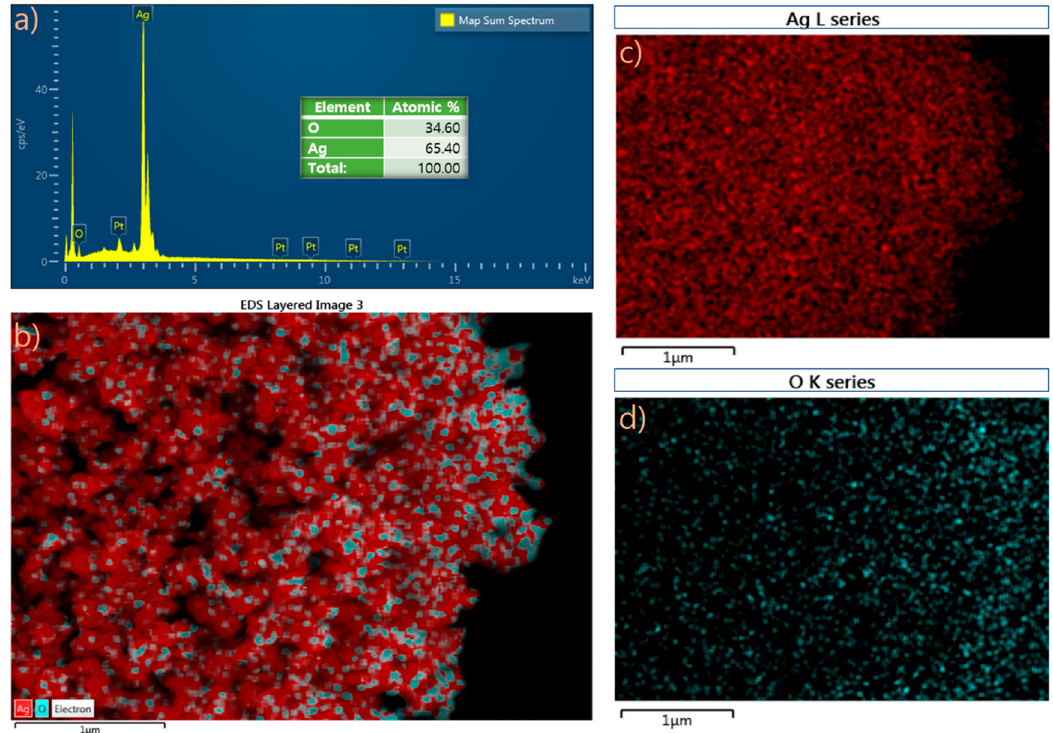
Figure 3. Energy-dispersive spectroscopy (EDS) elemental mapping of 1:4 ratio: ( a ) EDS spectrum and EDS element mapping images of combined O and Ag, ( b ) O, ( c ) and ( d ) Ag.